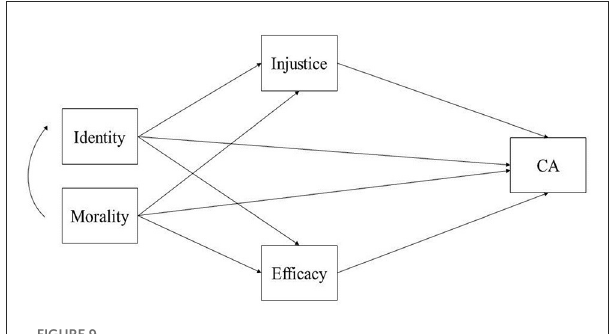
FIGURE9 Dual chamber model. Source: Agostini and van Zomeren (2021).